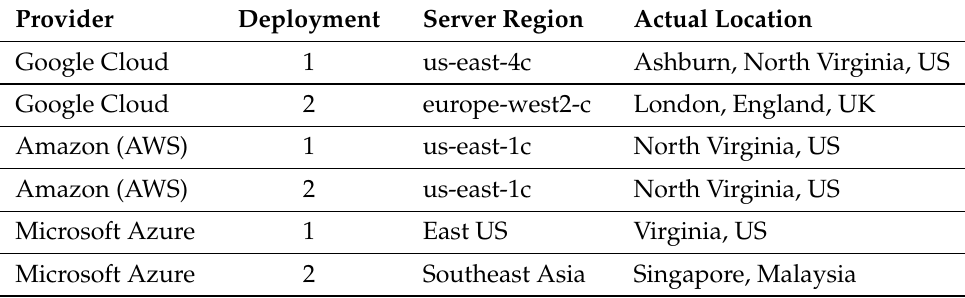
Table 1. Server Provider and Region Per